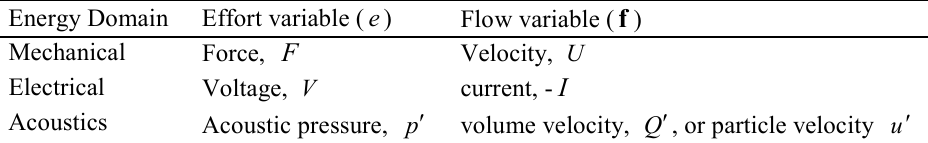
Table 1: Examples of effort and flow variables